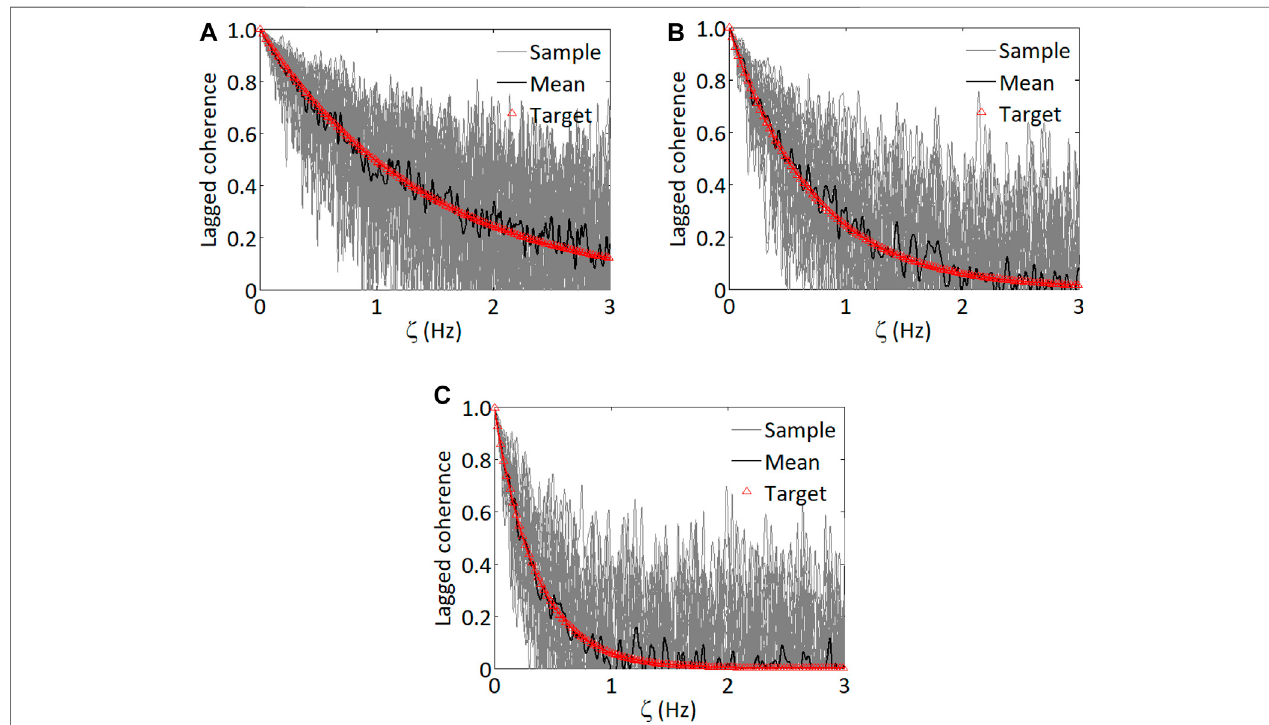
FIGURE 4 | Variation of the lagged coherence for different separation by considering 25 simulation cycles: (A) Separation equal to1.76 m, (B) Separation equal to 3.53 m, and (C) Separation equal to 7.06 m.